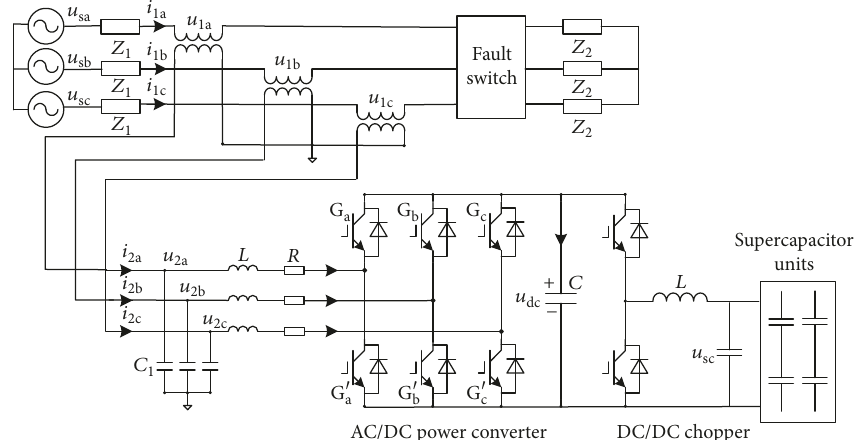
Figure 6: Demonstration of the experimental circuit for testing the active SFCL